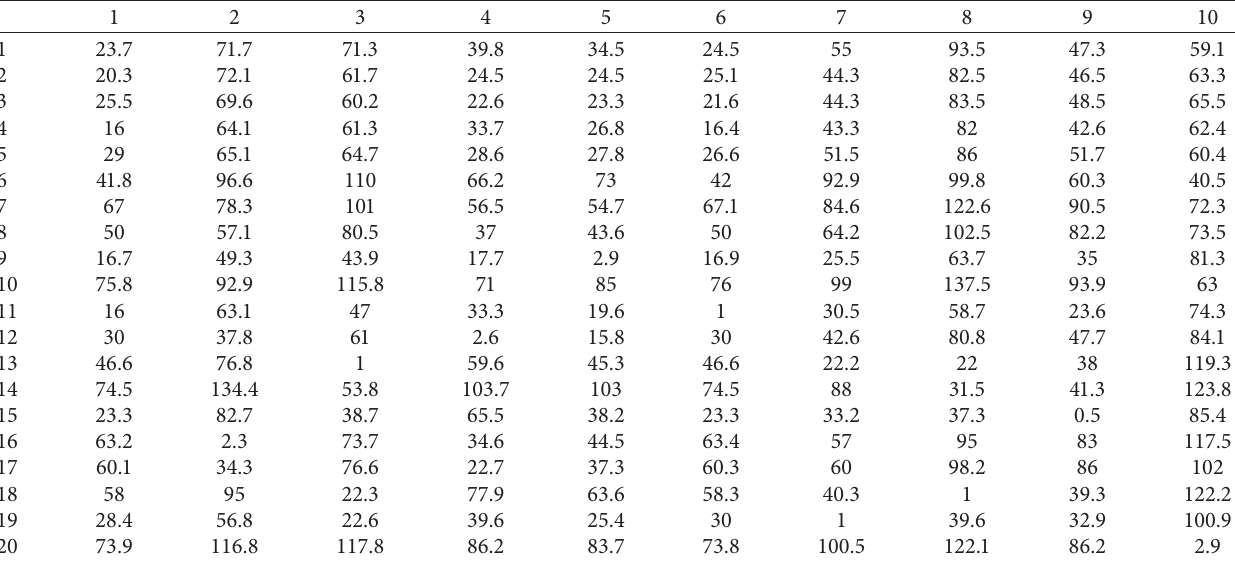
Table 6: Distance A ij from different groups to the blood donation house (unit: km).